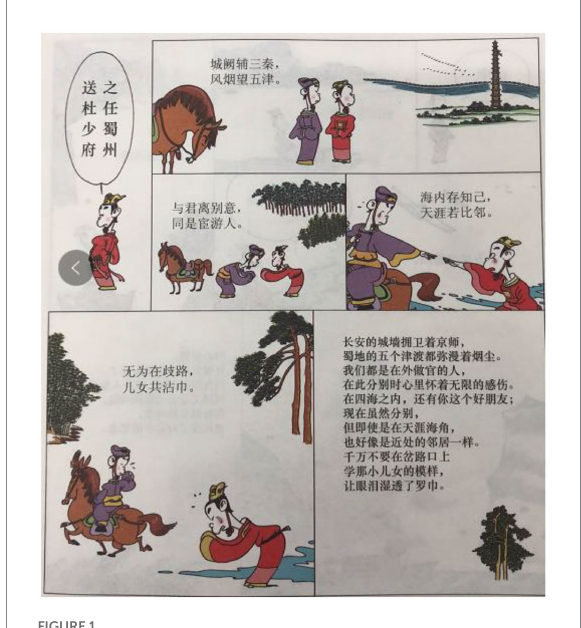
FIGURE 1 A complete poetry comic strip in Cai (2014, p. 3). Images reproduced with permission from Shang Dong People